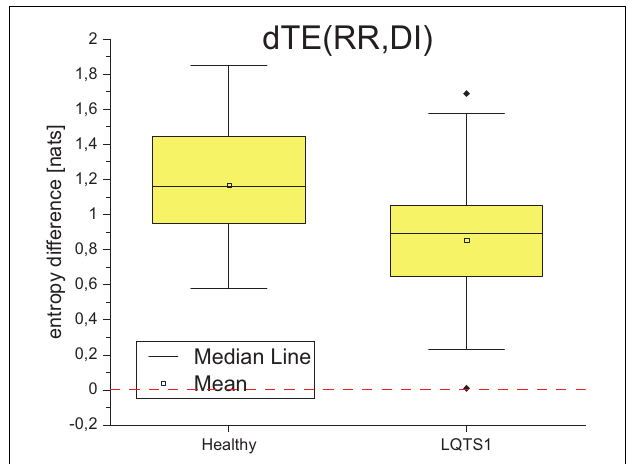
FIGURE 7 | (A) Probability density of the difference in the transfer entropy from the RR intervals to the QT intervals and in the opposite direction for healthy individuals and for LQTS1 patients. (B) Probability density of the difference in the transfer entropy from the diastolic intervals to the QT intervals and in the opposite direction for healthy individuals and for LQTS1 patients.